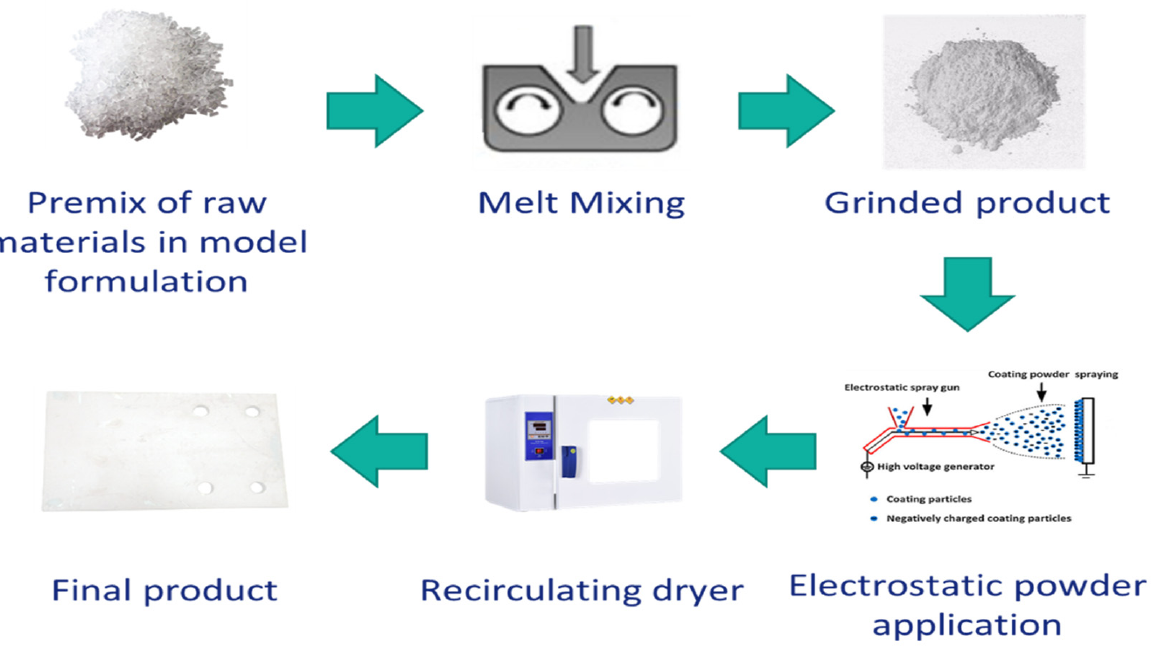
Figure 2. Steps from the preparation of powder coating system to obtain the final cured